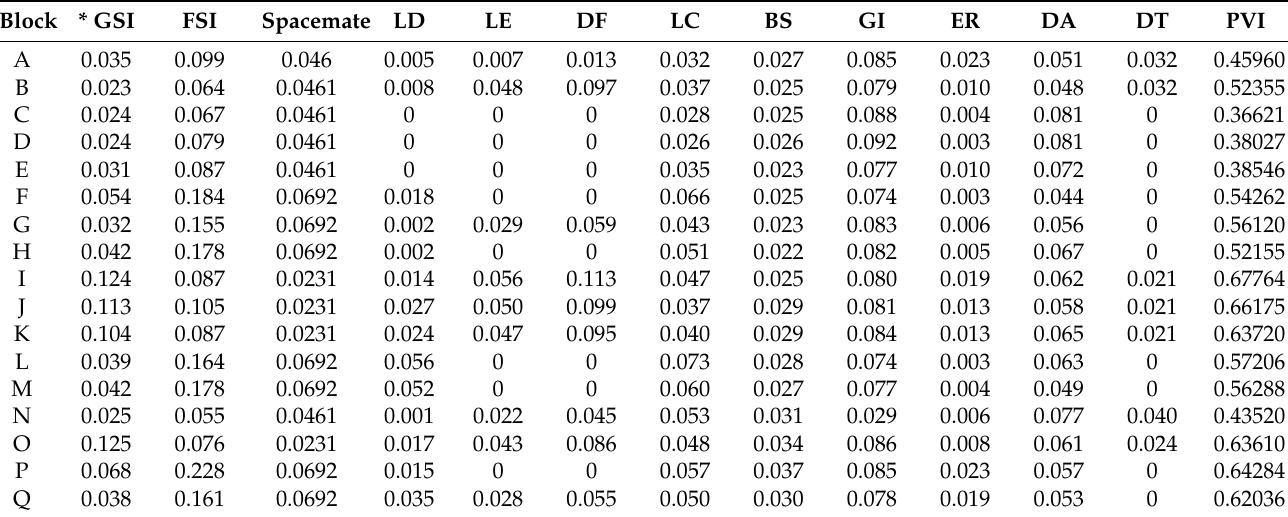
Table 6. AHP evaluation results for Potential Vitality Index